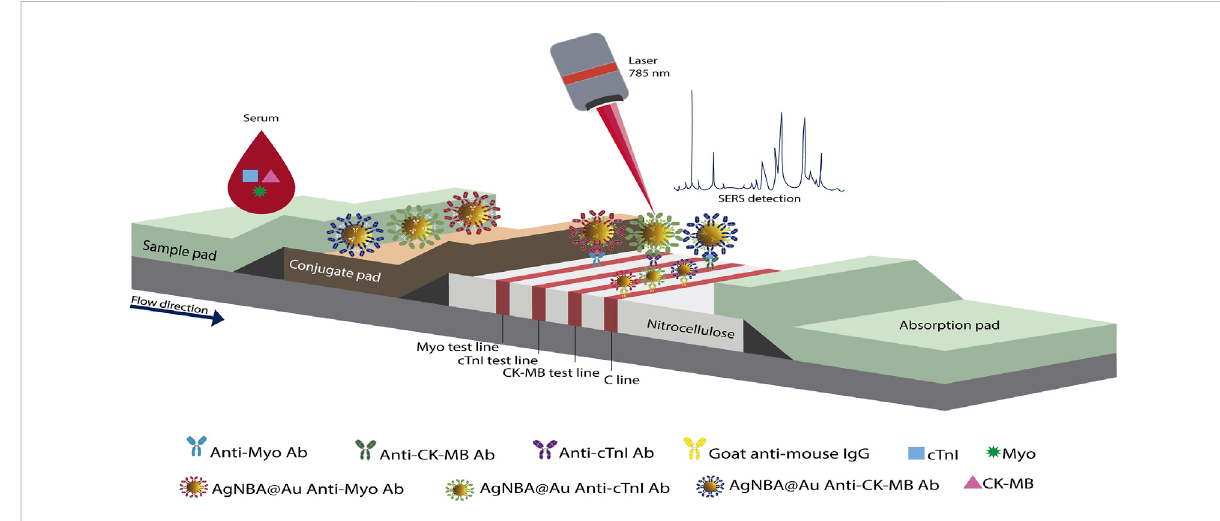
FIGURE 11 Schematic representation of the multiplex SERS-based lateral fl ow assay proposed by Zhang et al. (2018a).